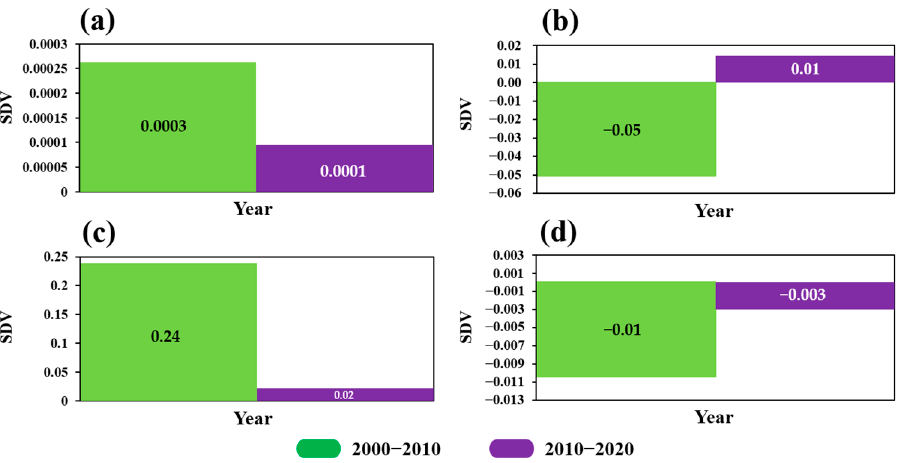
Figure 6. Changes in sustainable development indicator value (SDV) of urban agglomeration in the GBA. ( a ) is overall space; ( b ) is production space; ( c ) is living space; ( d ) is ecological space.